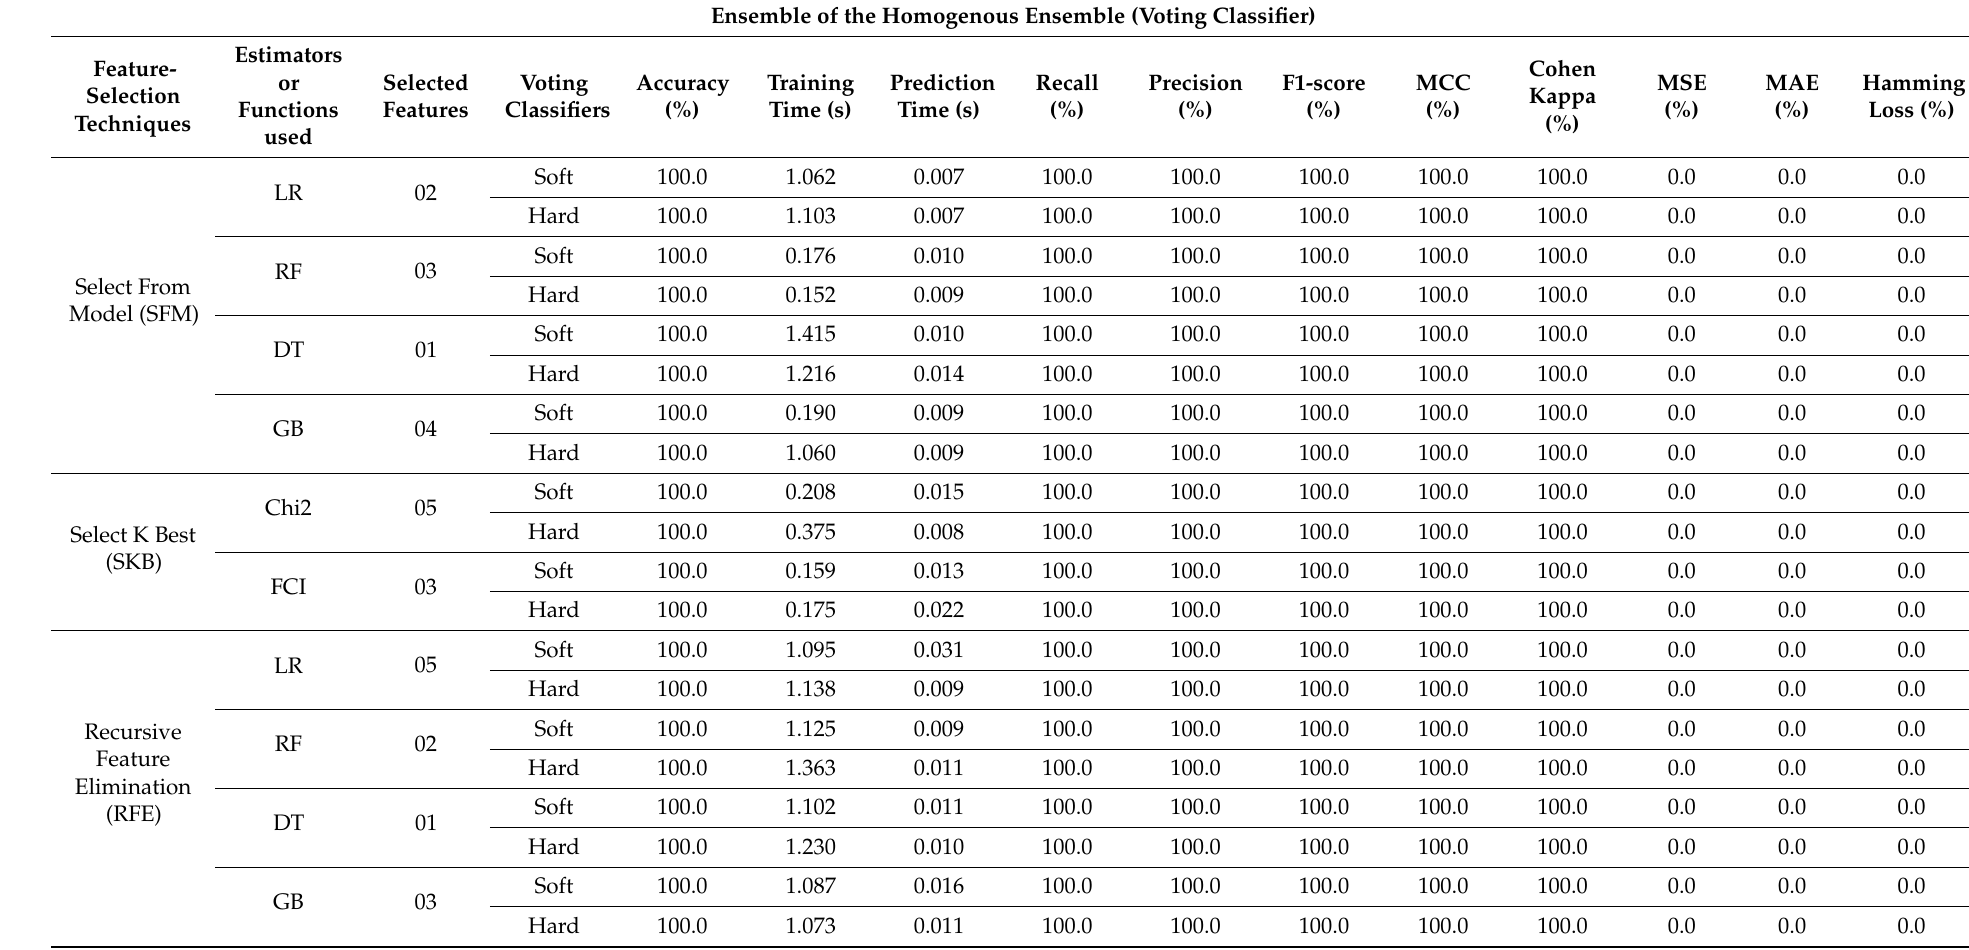
Table 6. Performance assessment measures for the soft and hard voting of the homogenous ensemble classifiers. Ensemble of the Homogenous Ensemble (Voting